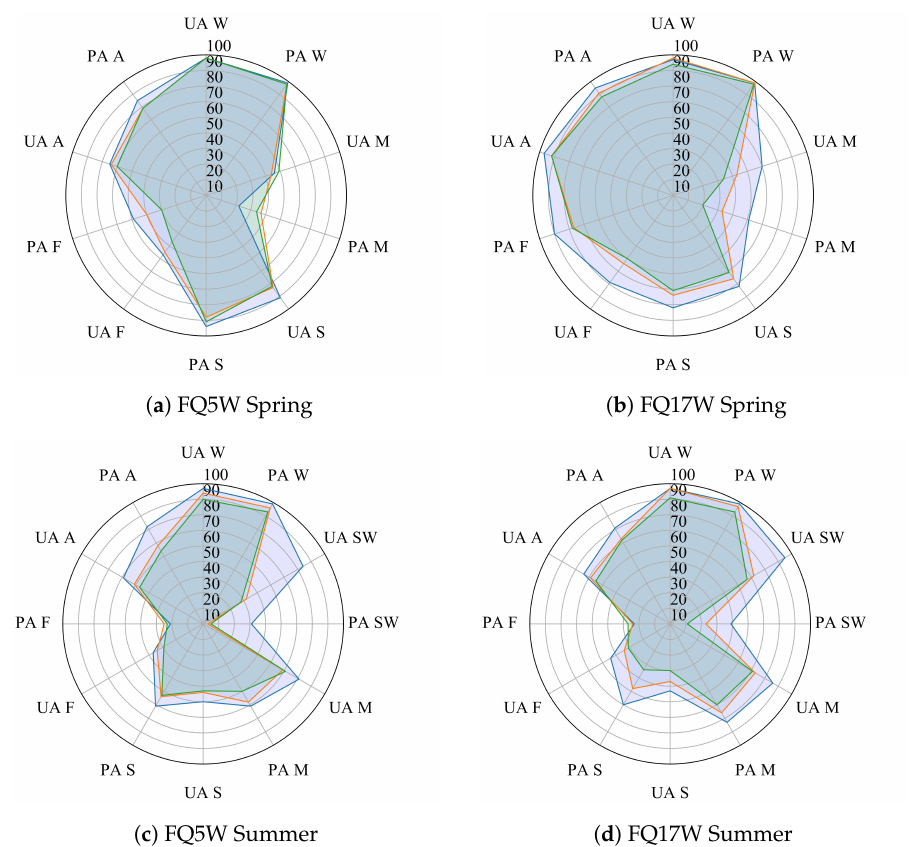
Figure 3. User’s (UA) and producer’s (PA) accuracies for water (W), shallow water (SW), marsh (M), swamp (S), forest (F), and agriculture/non-forested (A) for models based on single QP (blue), CP medium (orange), or CP high resolution (green)